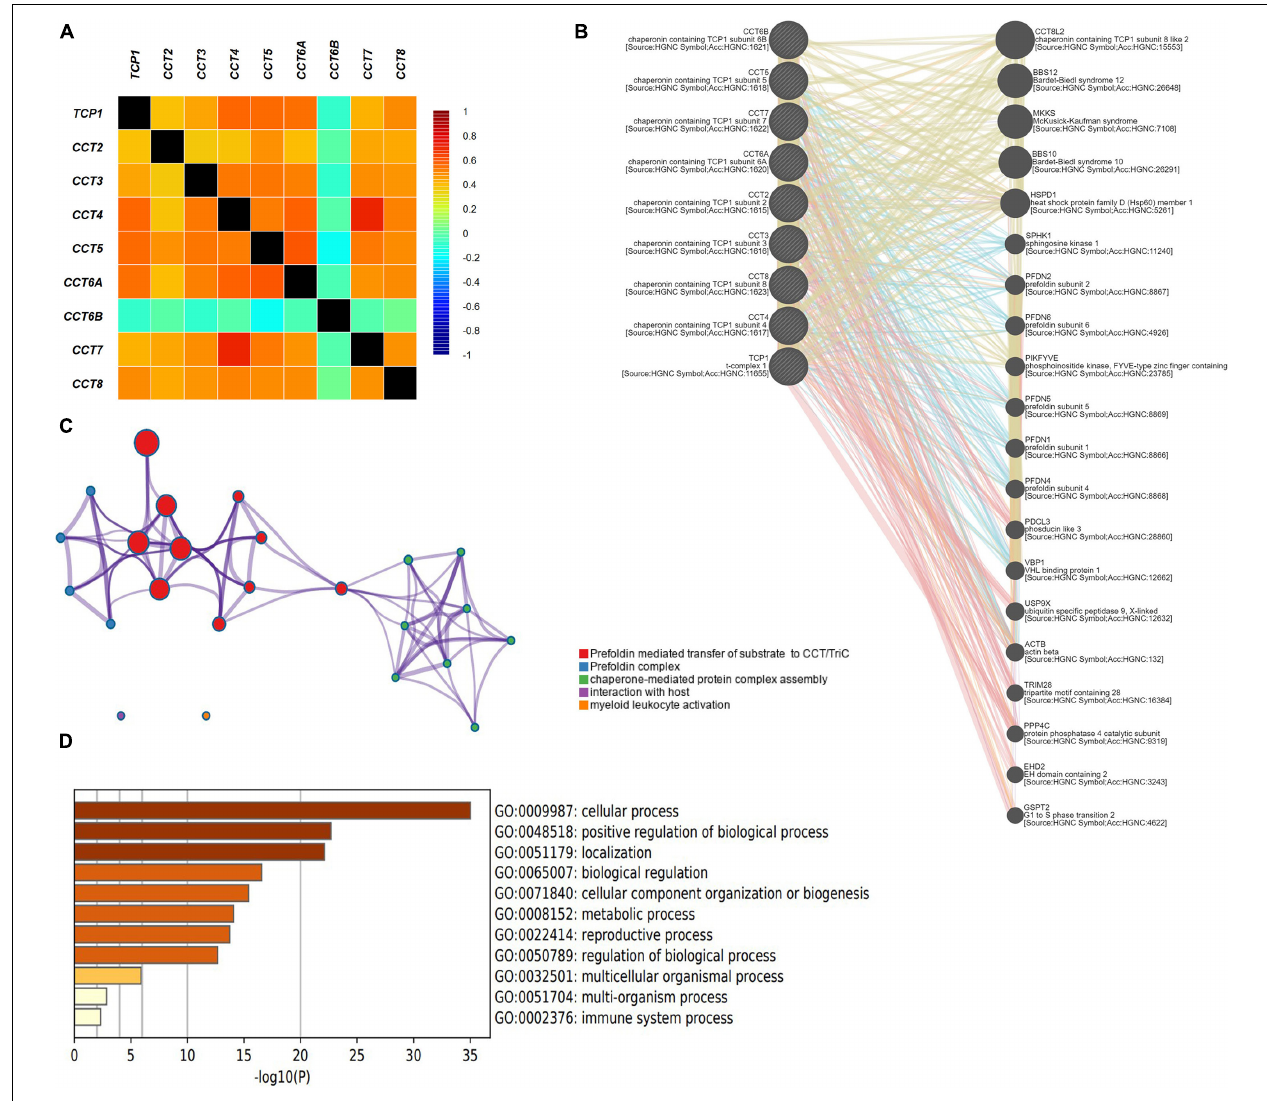
FIGURE 6 | Enrichment analysis (A) Pearson correlation analysis of eight subunits of the chaperonin TRiC. (B) Protein–protein interaction network among eight subunits of the chaperonin TRiC in the GeneMANIA dataset. (C) Interactive network of the top five enriched terms colored by cluster ID. Each color represents one enrichment pathway. (D) Heatmap of enriched terms regarding Gene Ontology biological processes across eight subunits of the chaperonin TRiC and its co-expressed genes constructed by